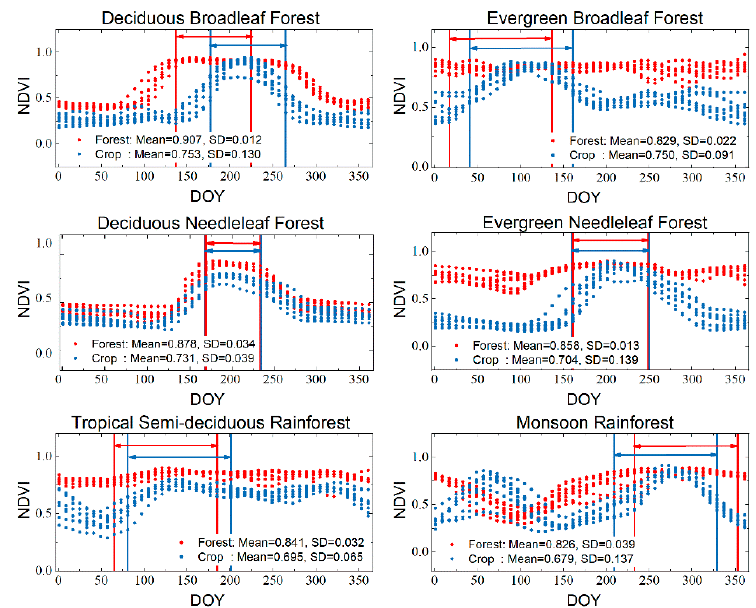
Figure 3. NDVI time series for various forest and adjacent cropland sites from 2010 to 2017, including deciduous broadleaf forest (Morgan Monroe State Forest, USA), evergreen broadleaf forest (AekLoba, Sumatra), deciduous needleleaf forest (Krasnoyarsk, Russia), evergreen needleleaf forest (Howland, USA), tropical semi-deciduous rainforest (Budongo Forest, Uganda) and monsoon rainforest (78.79° N, 15.56° E, India). Detailed information is shown in Table 1. Red and blue represent forests and crops, respectively, and the periods indicated by the arrows are the vegetation maturity period. The values of mean and SD in the figure refer to NDVI Maturity _ Mean and NDVI Maturity _ SD , respectively. Table 1. Information of forest and adjacent cropland sites in Figure 3. Fine-resolution images from Google Earth are also shown for each forest and cropland site.